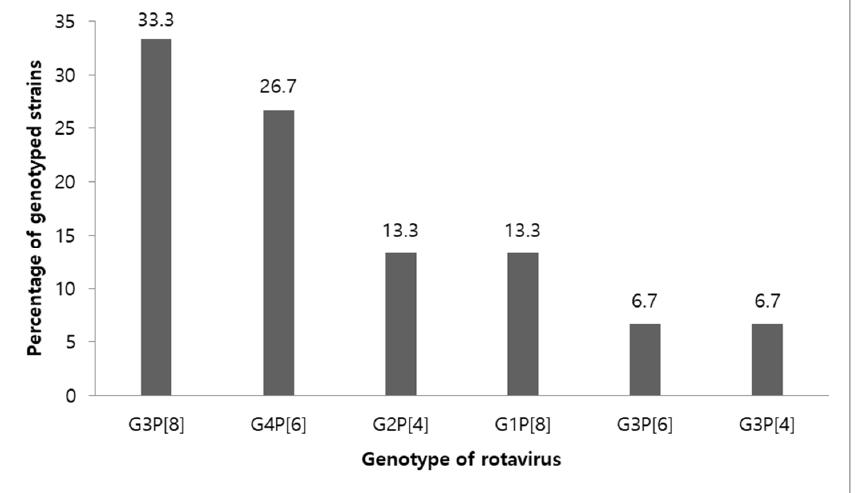
Figure 3. Genotype distribution in inpatient children with acute gastroenteritis less than 5 years ago.